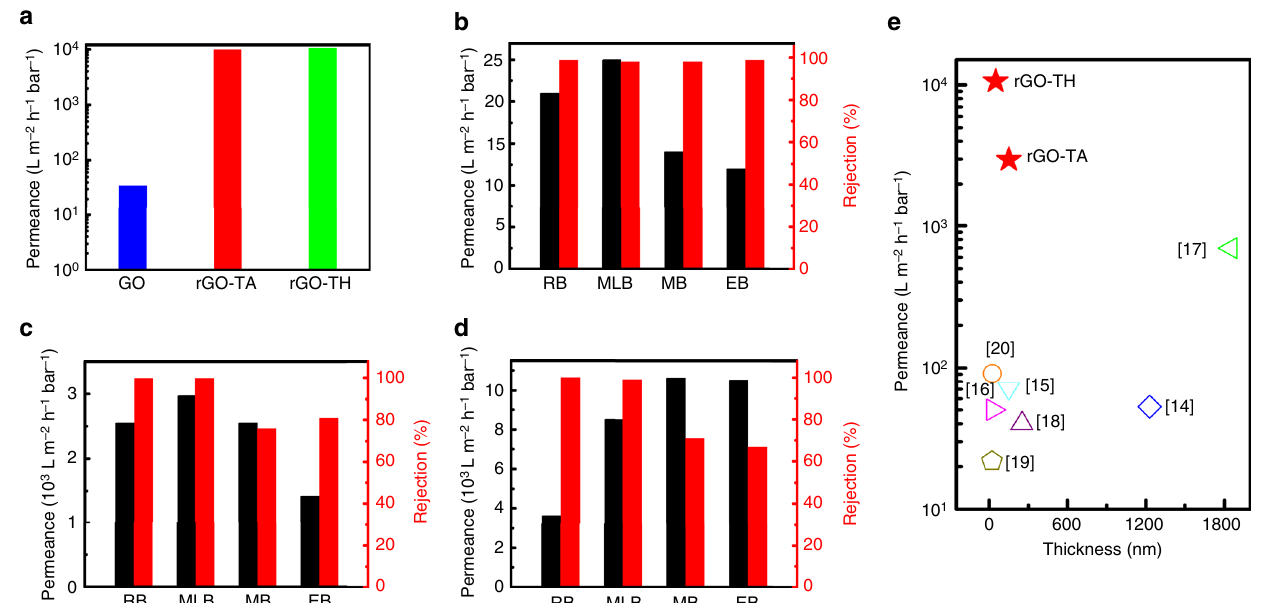
Fig. 3 Permeability and separation performance of GO-based membranes. a DI water permeance of GO, rGO – TH, and rGO – TA membrane at a transmembrane pressure of 1.0 bar. b – d Permeance and rejection of organic dyes (50 µ M) of GO ( b ), rGO – TA ( c ), and rGO – TH ( d ) membranes at a transmembrane pressure of 1.0 bar. GO membrane, 100 nm thick; rGO – TA membrane, 150 nm thick; rGO – TH membrane, 60 nm thick. e